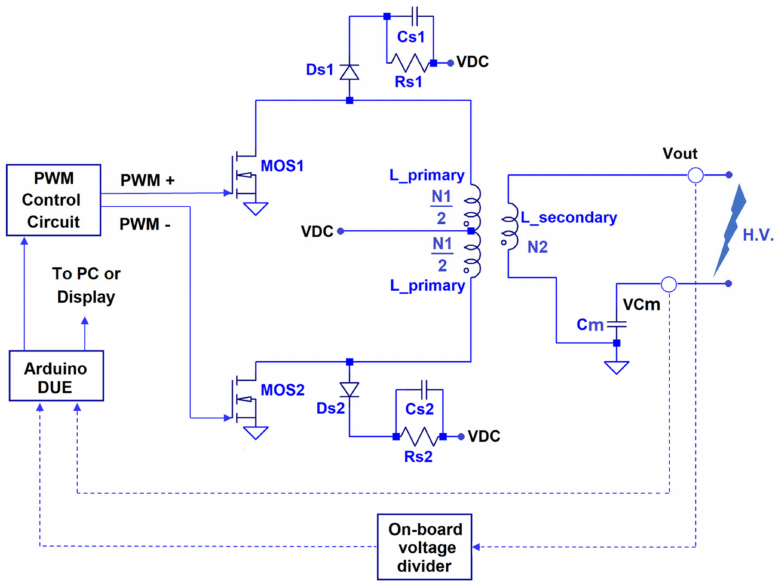
Figure 3. Electrical architecture of the supply